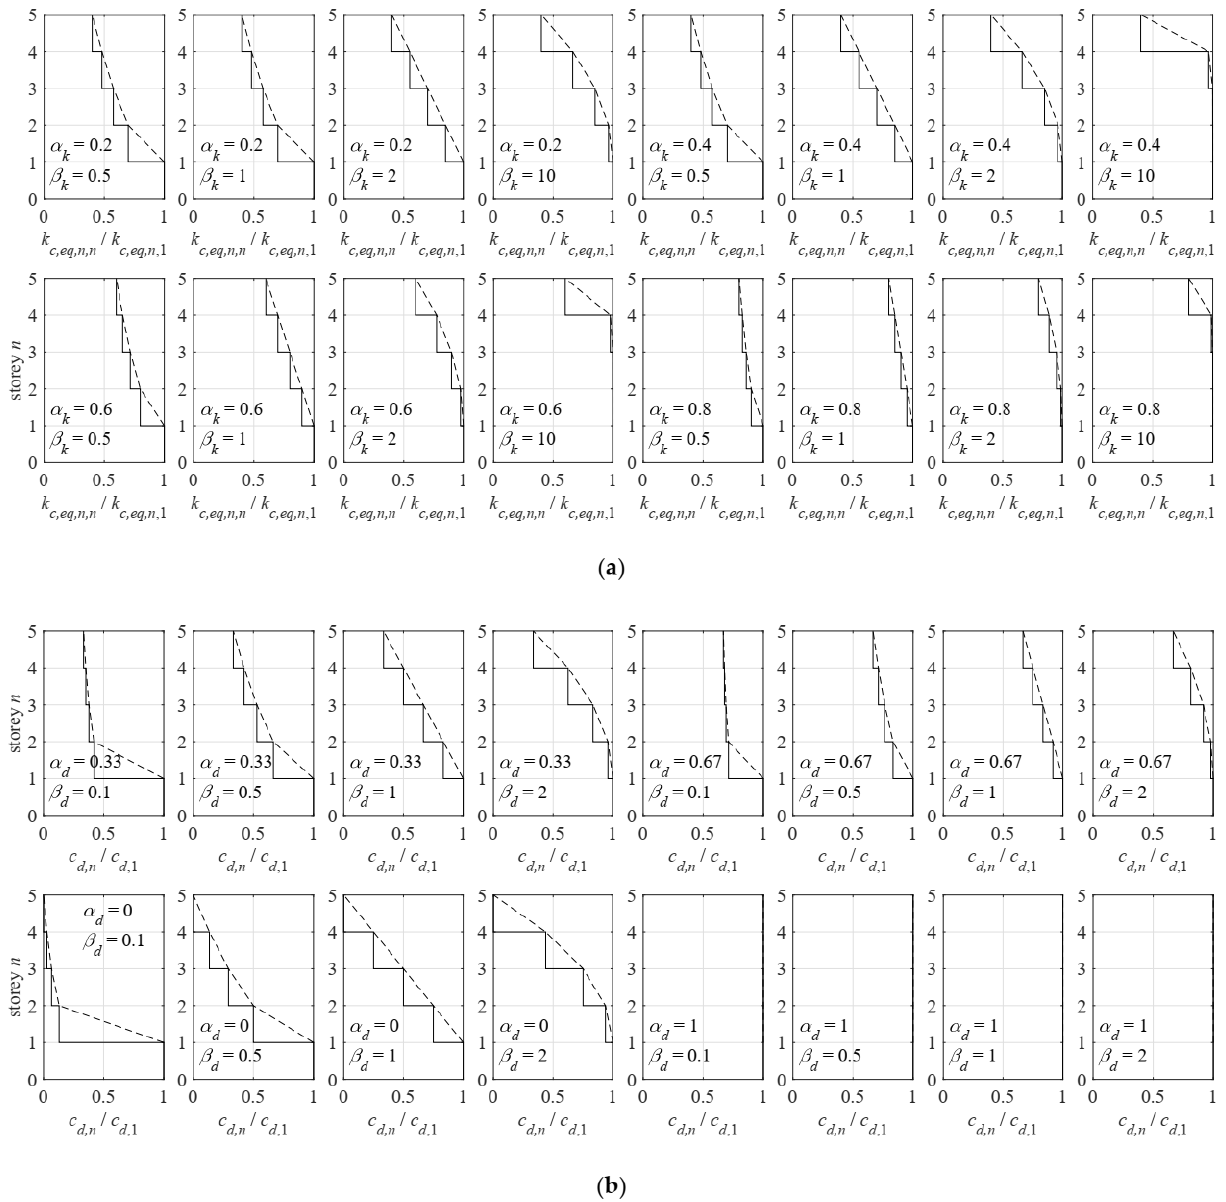
Figure 2. Vertical distributions considered in the study; ( a ) stiffness; ( b ) added